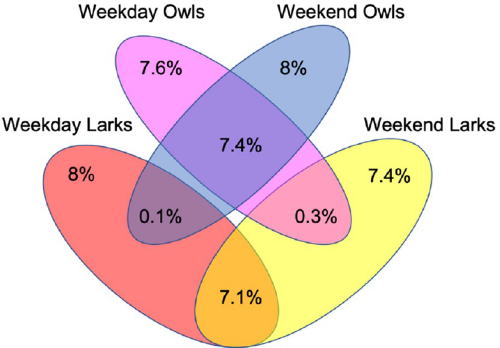
Figure 5. Venn diagram to show changes in larkish and owlish behaviour. The joint distribution of the larks and owls (excluding the third birds) obtained from classification of the chronotypes obtained by computing a PCA on T mid values for weekends and for weekdays separately and presented in the form of a Venn diagram. The colours red and pink represent all the larks and all the owls on the weekdays (including extreme larks and extreme owls). The blue and yellow represent all owls and all larks on weekends (including extreme larks and extreme owls). We observe that 7.1% of the population who are larks remain the same be it weekdays or weekends and similarly for 7.4% of the population that are owls. A very few percentage of the population ( 0.1% for larks and 0.3% for owls) changes their behaviour drastically to the opposite kind depending on whether it is a weekend or weekday. We also observe that 8% for larks and 7.6% for owls on weekdays; and 7.4% for larks and 8% for owls on weekends convert to third birds in the population.